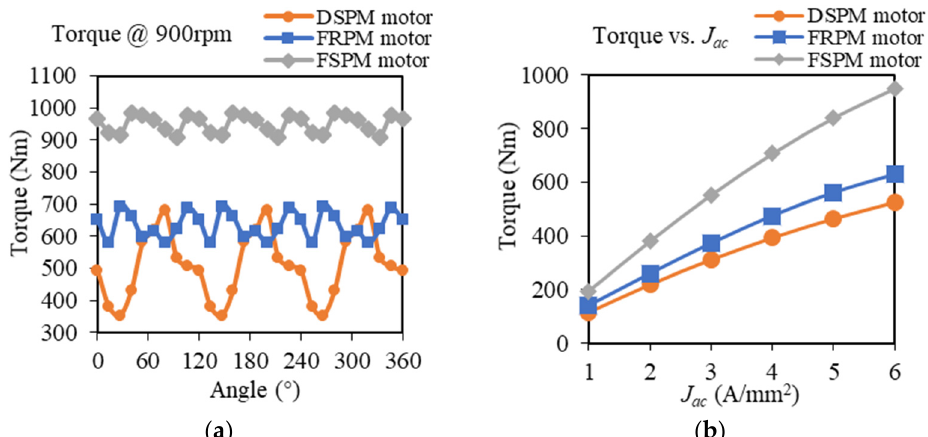
Figure 6. Torque performances of three AF-DR motors without MC current: ( a ) J ac = 6 A/mm 2 ; ( b ) different armature current densities.